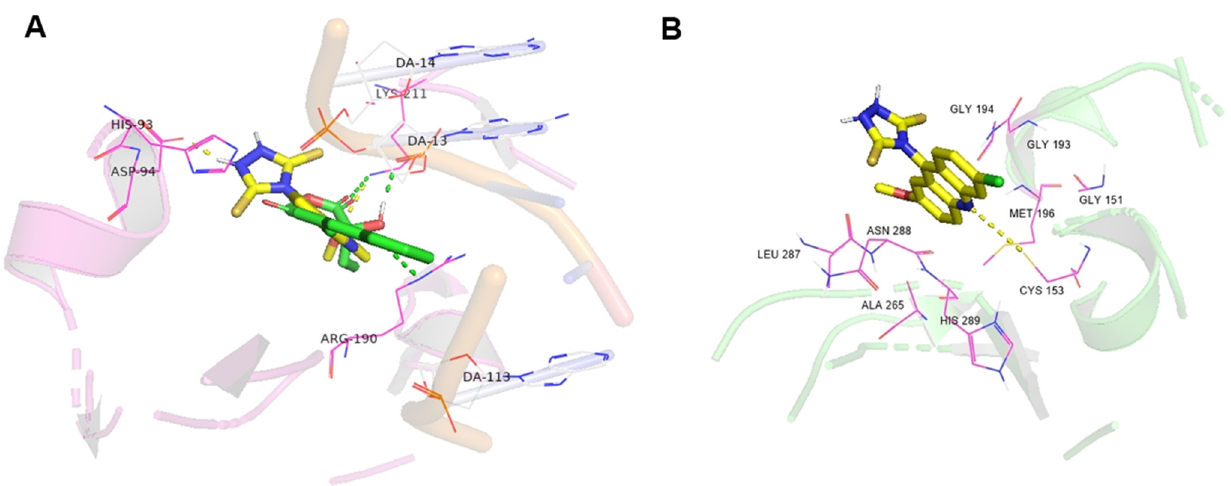
Figure 7. Docking analysis of Camptothecin (green) and ACW-02 (yellow) in LdTopo IB (PDB ID: 2B9S) ( A ), and ACW-02 with CPBLa ( B ). The polar interactions are highlighted as dashed lines in the respective colors of the derivatives studied.